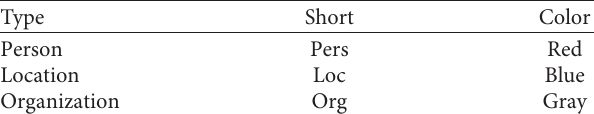
Figure 3: Operation stage of the proposed Table 8: Example of short and color tags.